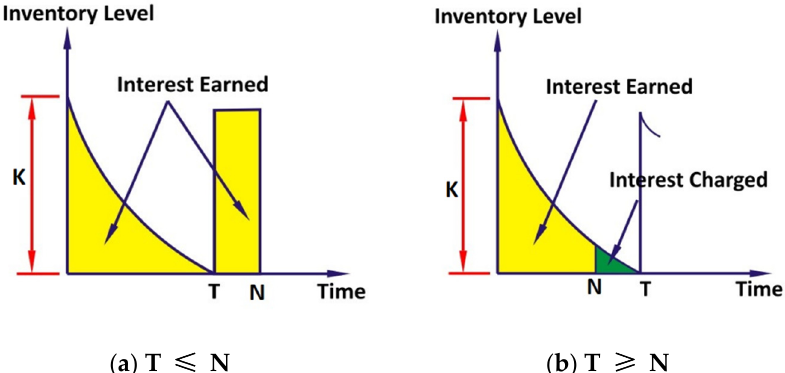
Figure 1. Graphical representation according to deferred period and replenishment cycle time.